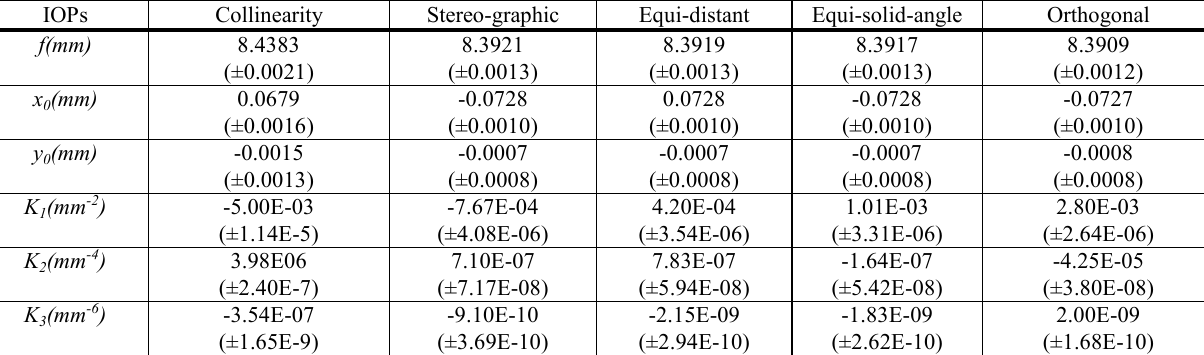
Table 4 - Estimated IOPs and standard deviations.